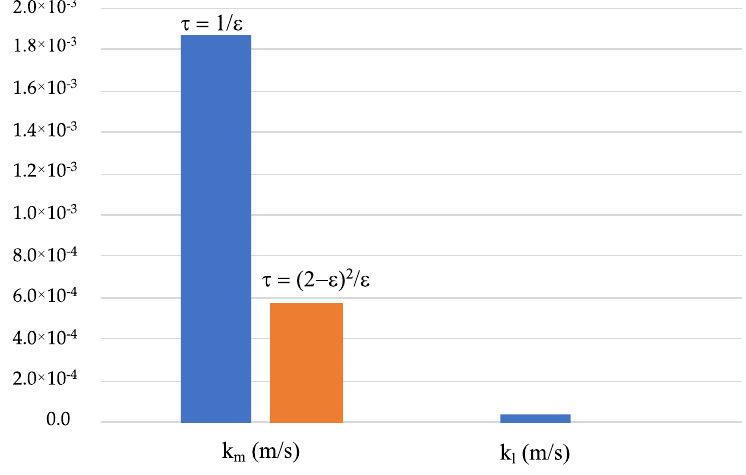
Figure 9. Comparison of the mass transfer coefficients.